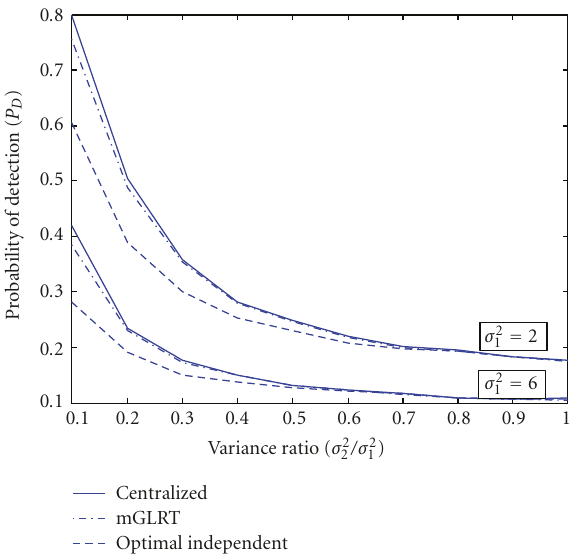
Figure 4: Performance of the mGLRT compared to the optimal independent test and the centralized detection with complete observations at P F = 0 . 05 as the variances of the sensors become closer to each other for κ i = 0 . 5, ρ = 0 . 5, and σ 2 1 = 2,6.